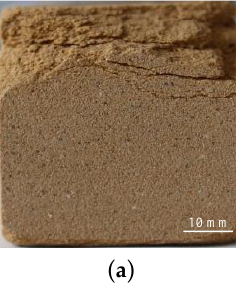
Figure 7. Variation characteristics of macroscopic morphology of rock samples under different freeze–thaw modes. ( a ) Immersion freeze–thaw 60 cycles; ( b ) immersion freeze–thaw 60 cycles; ( c ) immersion freeze–thaw 60 cycles.